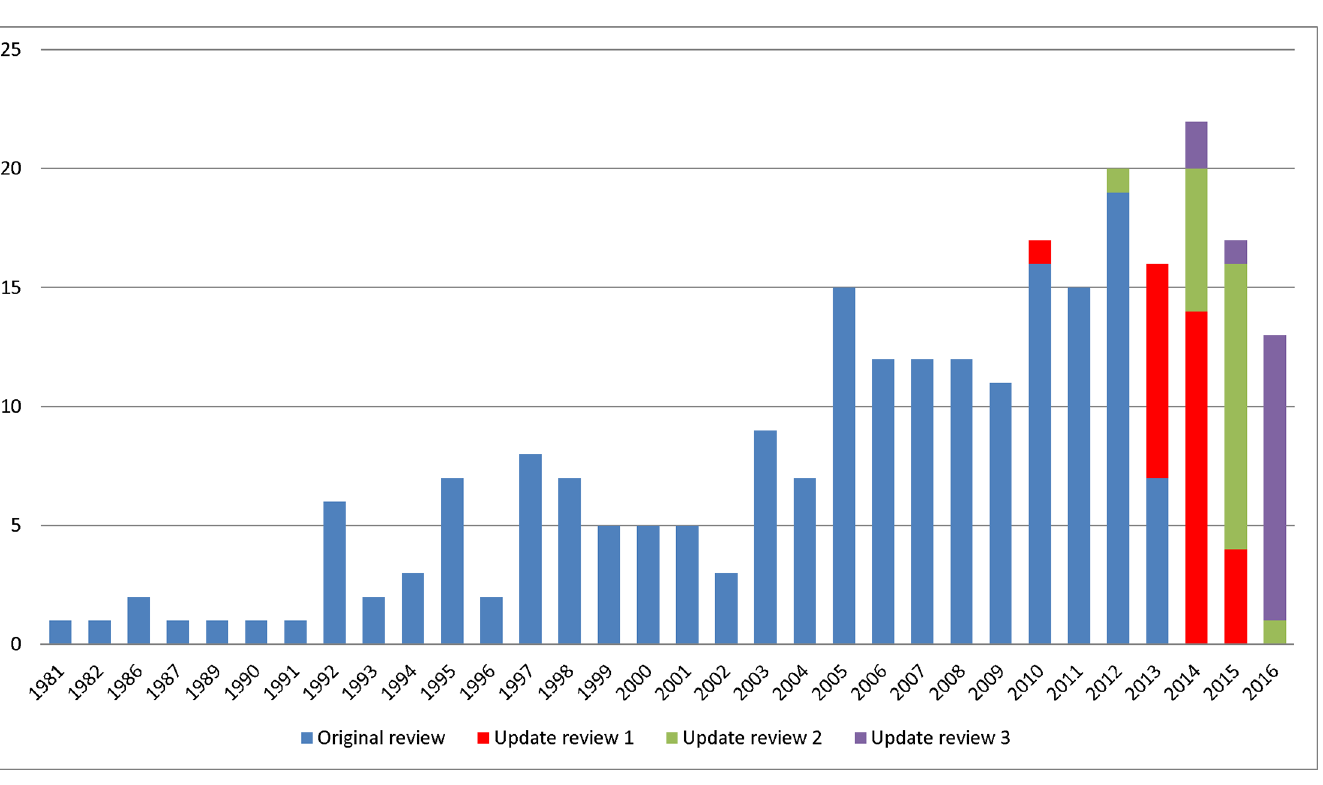
Fig 2. Year of first publication of each COS study (n =